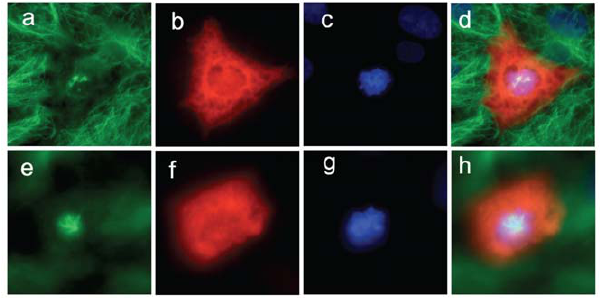
Figure 2. Spindle morphology in failed mitoses. Representative examples of cells which failed to complete mitosis following injection with either 4 U (panels a–d) or 1A11 (panels e–h). Fluorescently labelled dextran (red; panels b, d, f and h) indicates a successful microinjection. Immunostaining with an anti-tubulin antibody (green; panels a, d, e and h) reveals that these cells do not contain a properly organised mitotic spindle. Condensed DNA is revealed by the addition of DAPI (blue; panels c, d and g, h) Panels d and h show the merged images. Scale bar=5 m M.